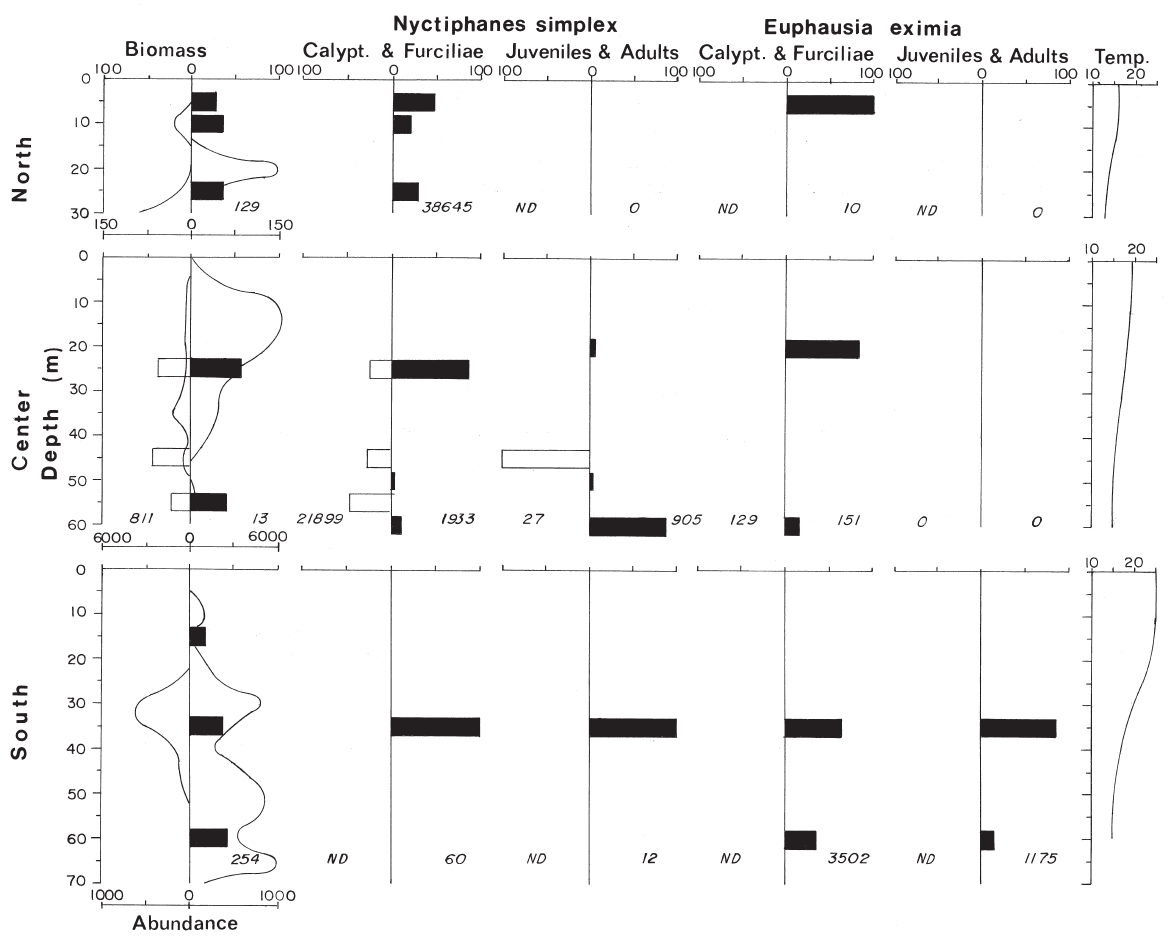
F IG . 4. – Vertical distribution of zooplankton biomass estimated by Bongo net (bars expressed in percentage, the italic number is the biomass expressed as mL 1000 m -3 ), zooplankton abundance measured by the echosounder (continuous line; echoes between -53 and -57 dB expressed as ind ha -1 ), and vertical distribution of two of the most abundant euphausiid species Nyctiphanes simplex and Euphausia eximia in the three latitudinal regions expressed as relative abundance. White bars are day samples and black bars are night samples. The italic numbers are the total abundance integrated over all strata expressed as ind 1000 m -3 . In the north and central areas, coastal stations are shown. In the southern area, the offshore stations where the SSL and these species were more abundant are